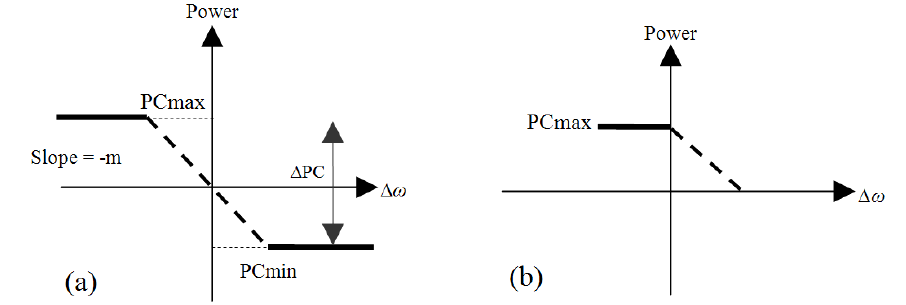
Figure 7. Power control for DGs: ( a ) Bidirectional; ( b ) Unidirectional [75].